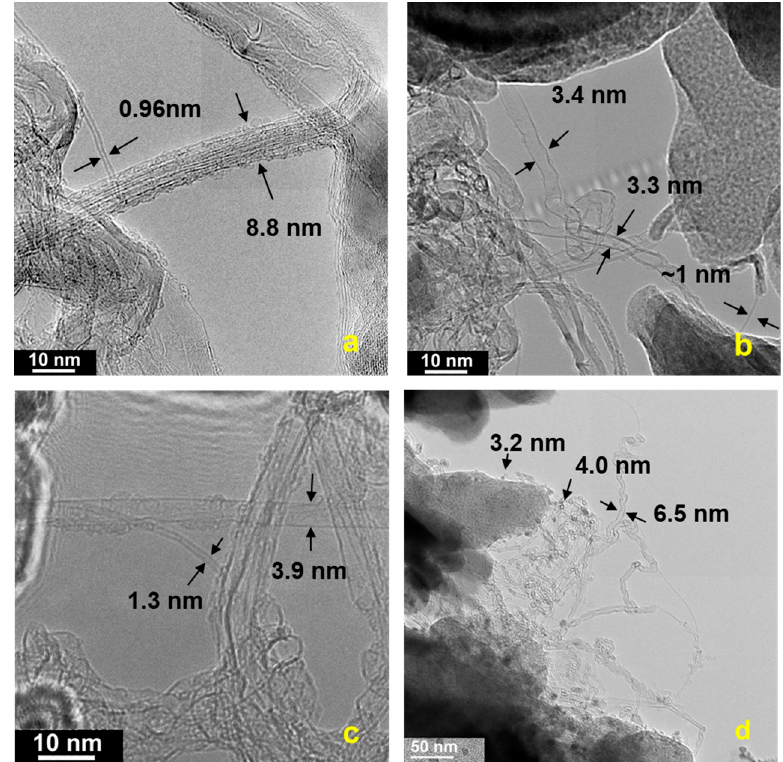
Figure 1. TEM images of raw carbon soot grown on kaolin sized paper showing ( a ) roped single-walled carbon nanotubes (SWCNTs) helically wrapped by a SWCNT, and large SWCNTs, ( b ) collapsed, ( c ) folded, and ( d ) twisted nanotubes. Scale bar = 10 nm ( a – c ) and 50 nm ( d ).